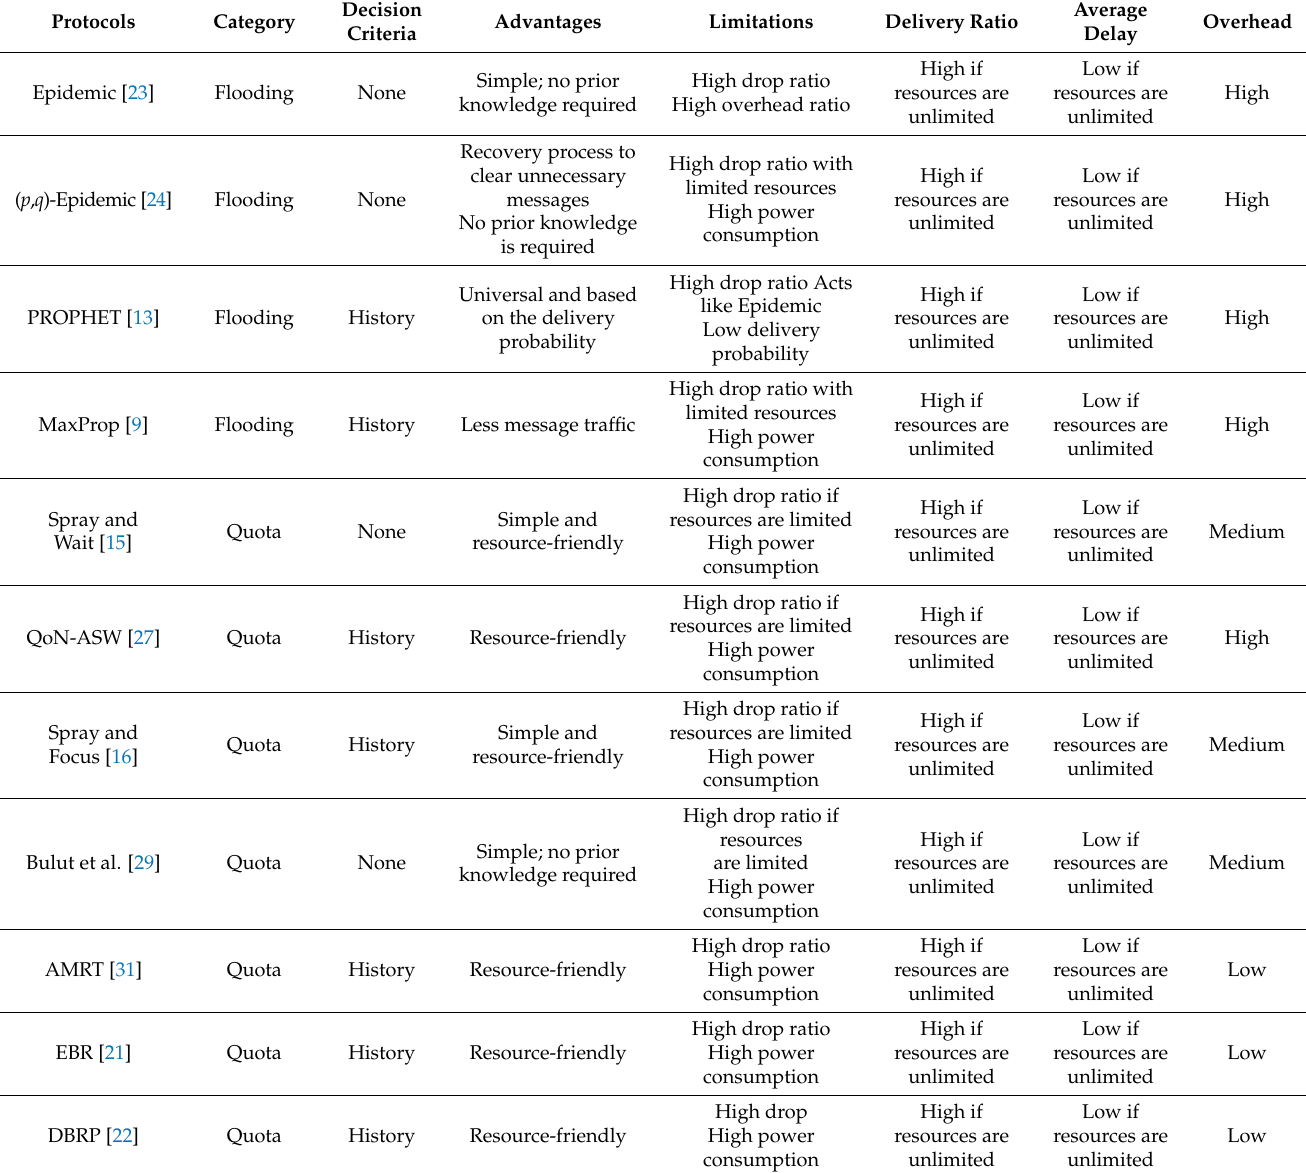
Table 1. Comparison of the various DTN